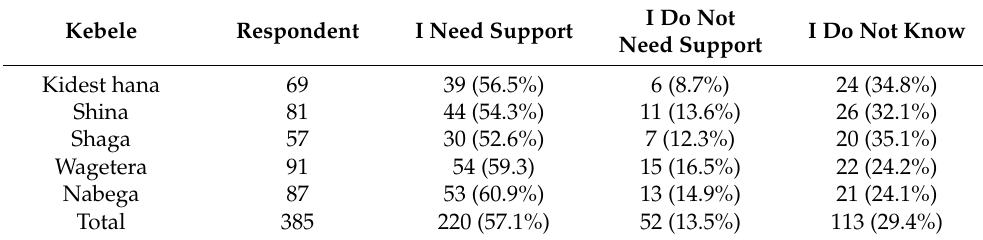
Table 10. The interest of farmers about the intervention of the NABU in wetlands.